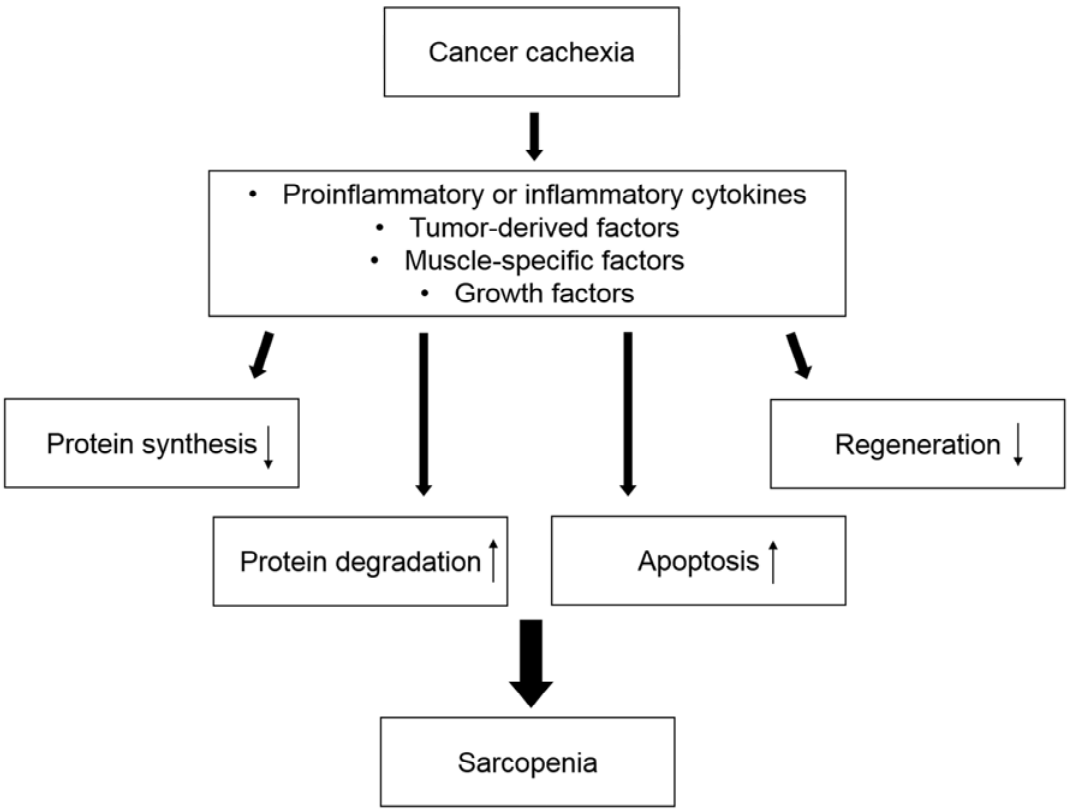
Figure 1. An outline of sarcopenia development in cancer cachexia. Sarcopenia is caused by decreased protein synthesis, increased protein degradation, upregulated apoptosis, and downregulated skeletal muscle regeneration. Various mediators are involved in these processes.